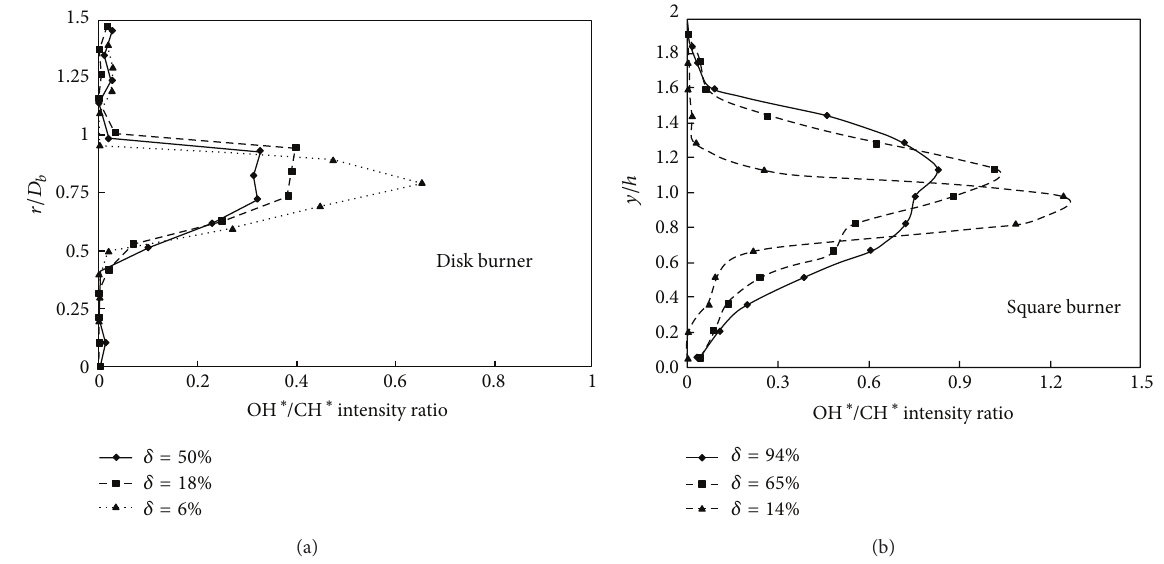
Figure 10: Cross-stream profiles of the ratio of the mean OH ∗ to CH ∗ chemiluminescence across the flame front within the recirculation zone for three ultra-lean and limiting flame settings, (a) disk and (b) square burner. Chemiluminescence profiles were taken at 𝑥/𝐷 𝑏 = 0.44 for the disk and at 𝑥/ℎ = 1.6 for the